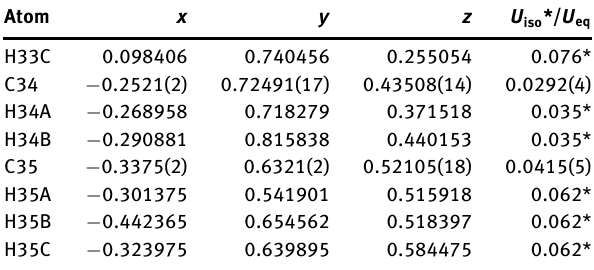
Table 2: Fractional atomic coordinates and isotropic or equivalent isotropic displacement parameters (Å 2